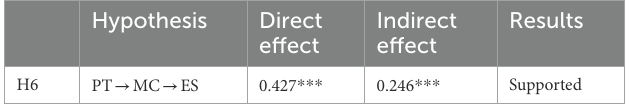
TABLE 6 Mediation Analysis.